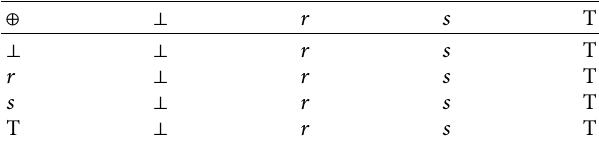
Figure 3: Illustration of M. Table 3: Binary operation subject to ⊕